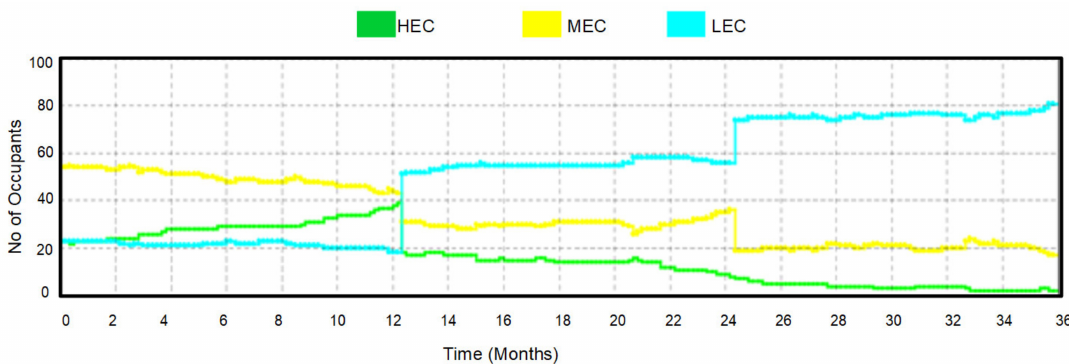
Figure 4. Occupants behavior change over